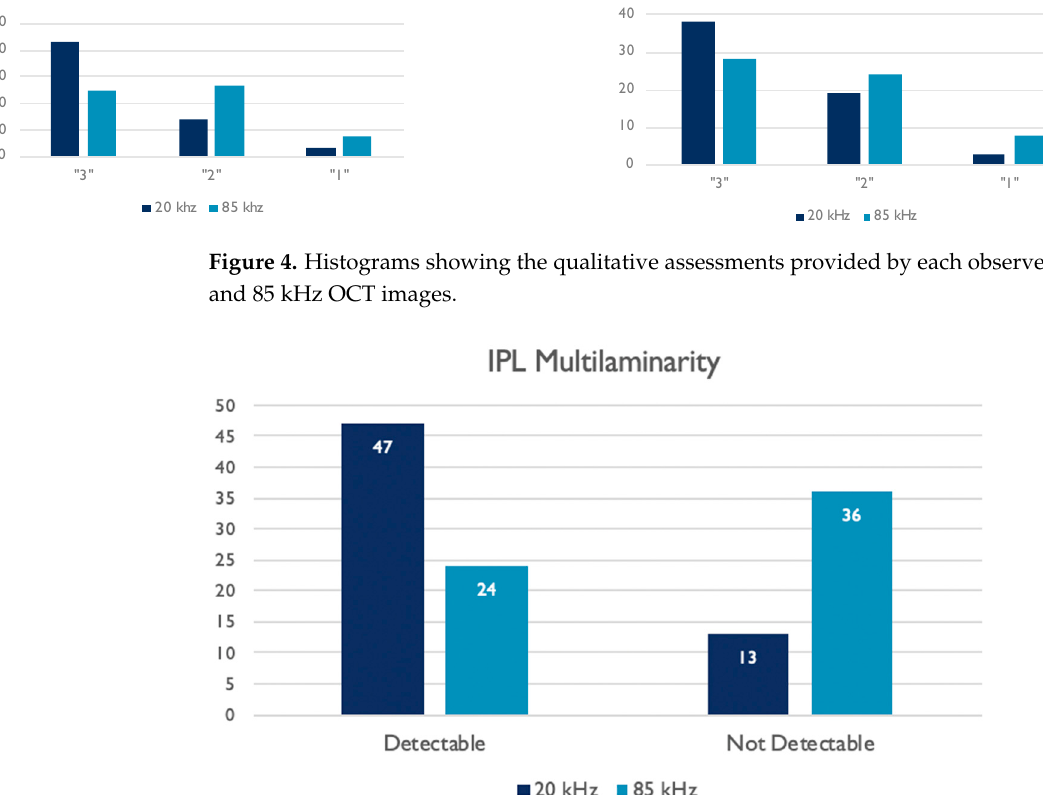
Table 4. Contingency table showing the number of images in which the IPL multilaminarity was detectable for the two di ff erent A-scan rate acquisitions.